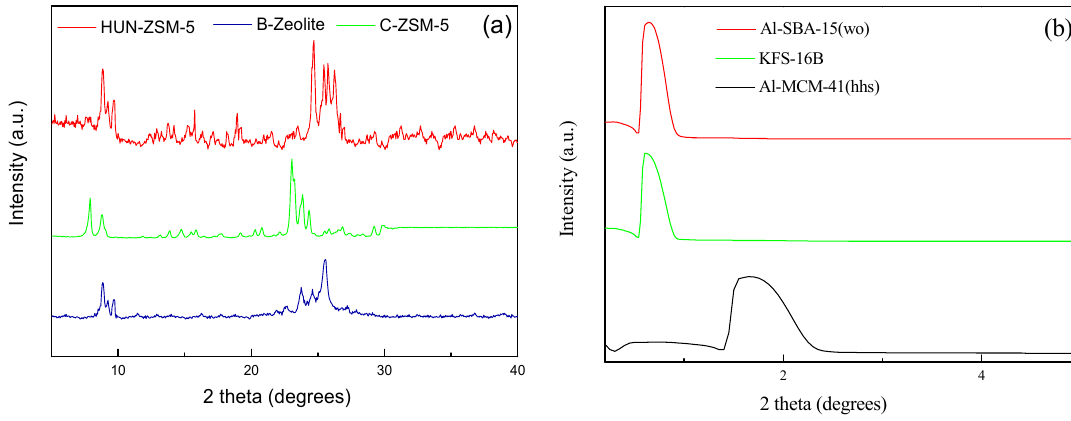
Figure 4. X ‐ ray powder diffraction (XRD) patterns of the six catalysts: ( a ) HUN ‐ ZSM ‐ 5, B ‐ Zeolite and Figure 4. X-ray powder diffraction (XRD) patterns of the six catalysts: ( a ) HUN-ZSM-5, B-Zeolite and C ‐ ZSM ‐ 5; and ( b ) Al ‐ SBA ‐ 15(wo), KFS ‐ 16B and Al ‐ MCM ‐ 41(hhs). C-ZSM-5; and ( b ) Al-SBA-15(wo), KFS-16B and The diffractograms of Al ‐ MCM ‐ 41(hhs), KFS ‐ 16B and Al ‐ SBA ‐ 15(wo) presented the main diffraction peak (100 reflection) at 2 θ of 1.9°, 0.9° and 1.0°, respectively. All the peaks were